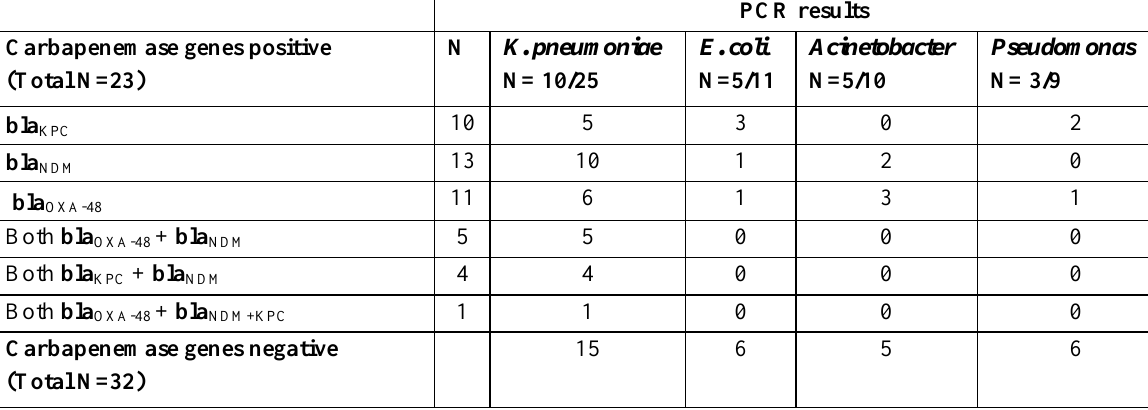
Table 4. Frequency of carbapenemase genes detected in CR Gram-negative